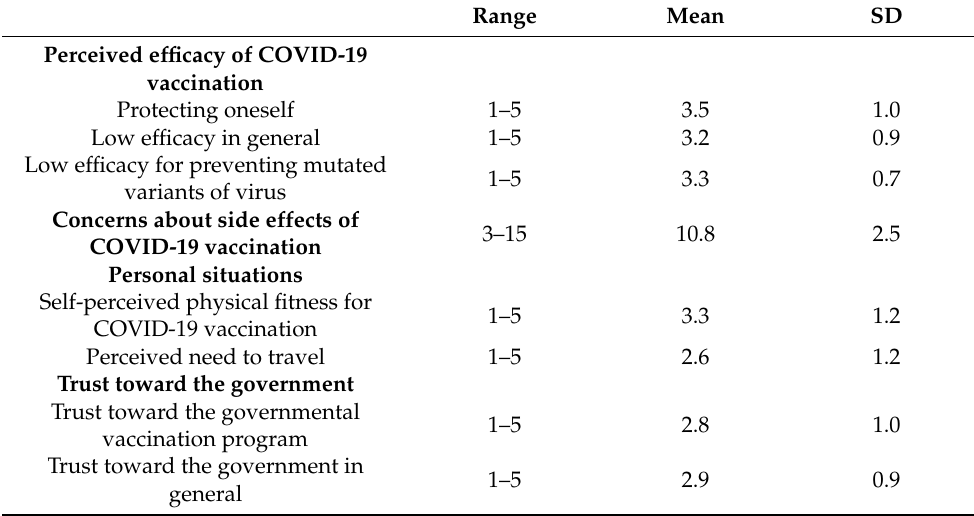
Table 2. Descriptive statistics of the continuous independent variables (n =